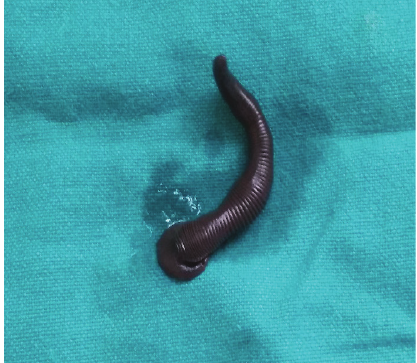
Figure 2: Alive leech